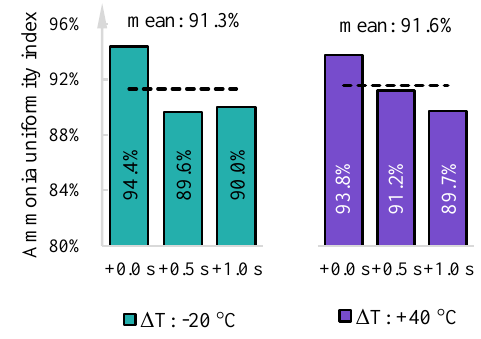
Fig. 9. Ammonia uniformity index at a gas mass flow rate of 300 kg/h, all subcases listed Despite the lack of mixing elements, the uniformity of the ammonia distribution reached an excellent and compa- rable level regardless of the gas mass flow rate. Firstly, the flow in the mixing chamber was subjected to intense turbu- lence and streamline deflections according to the predic- tions. Streamlines of the exhaust gas flow are presented in Fig. Fig. 7. The local temperature in the vicinity of the impingement plate mapped on its surface at the time of the maximum temperature drop, mass flow rate: 300 kg/h; a. subcooled spray, 10 ms ASOI; b. superheated spray, 29 ms ASOI